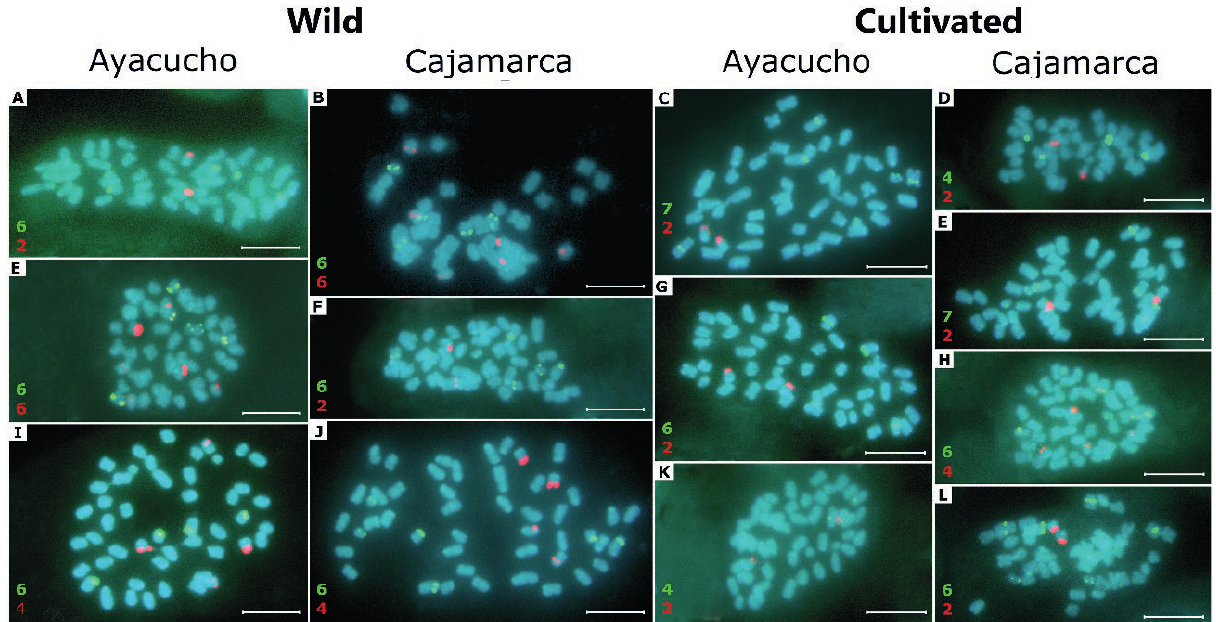
Figure 2 Fluorescent in situ hybridization signals of the 5s (green) and 45s (red) rDNA probes in Physalis peruviana L. metaphase chromo- somes. Th e numbers at the bottom left of each image represent the number of 5s (green) and 45s (red) sites found in the metaphases. Com- binations of the number of 5s and 45s rDNA sites identifi ed in the population of wild Ayacucho are shown in A, E, and I; wild Cajamarca is shown in B, F, and J; cultivated Ayacucho is shown in C, G, and K; and Cultivated Cajamarca is shown in D, E, H, and L. Th e scale bar measures 10 μm.